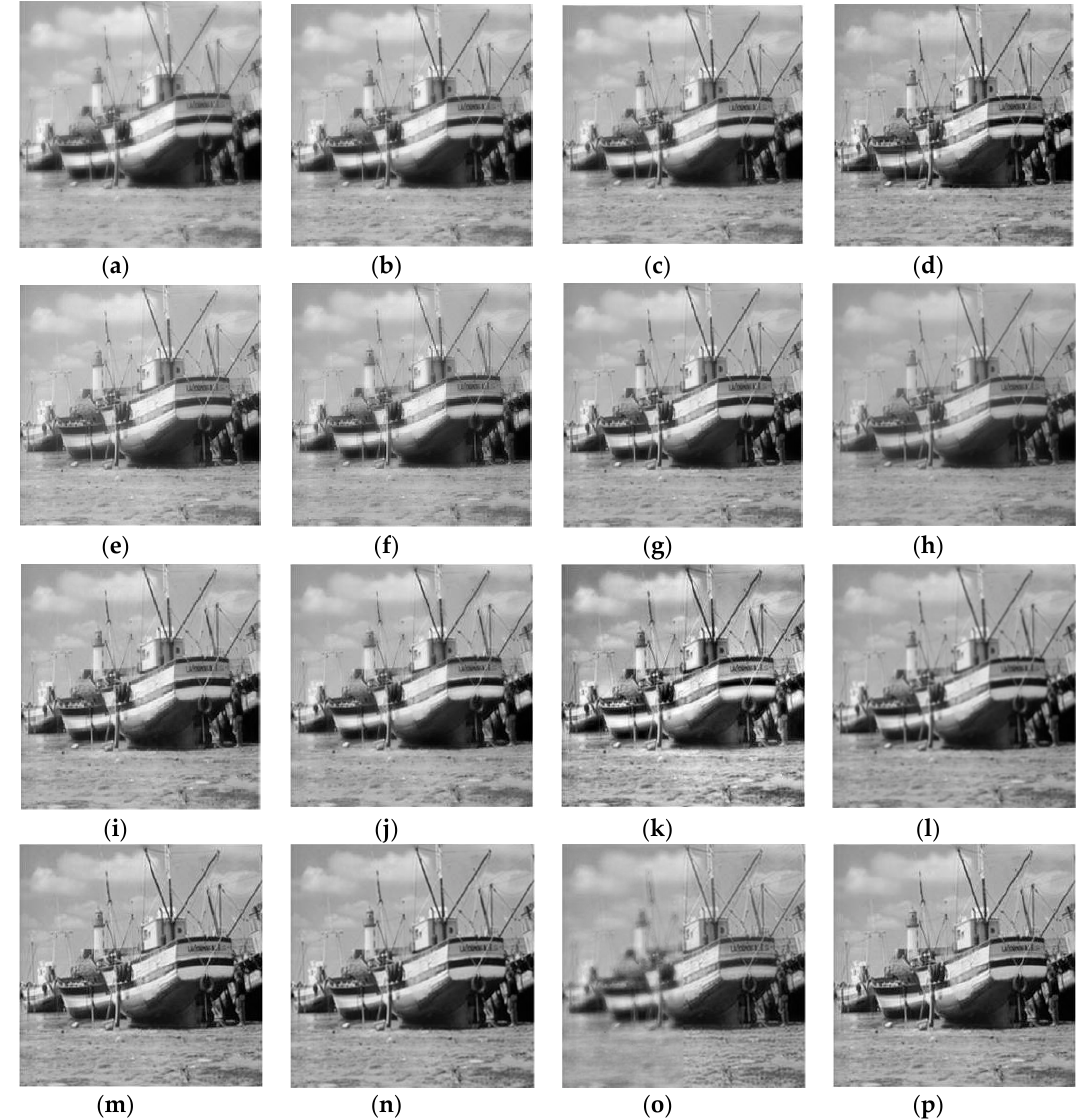
Figure 7. Fused images obtained by different methods in the image pair “boat”. ( a ) PCA; ( b ) SWPCA;